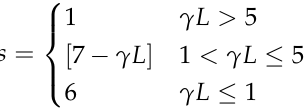
γ  and true coherence mag- s , using numerical calculation.